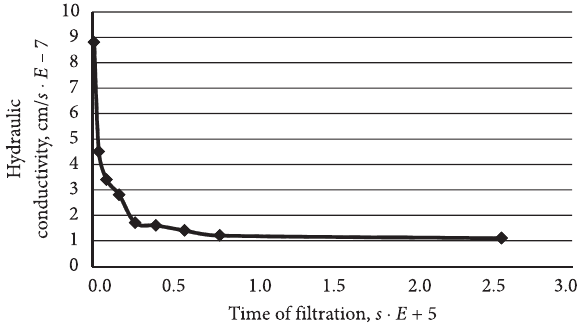
Fig. 6. Variations of clay hydraulic conductivity during the initial filtering performed after thawing of the